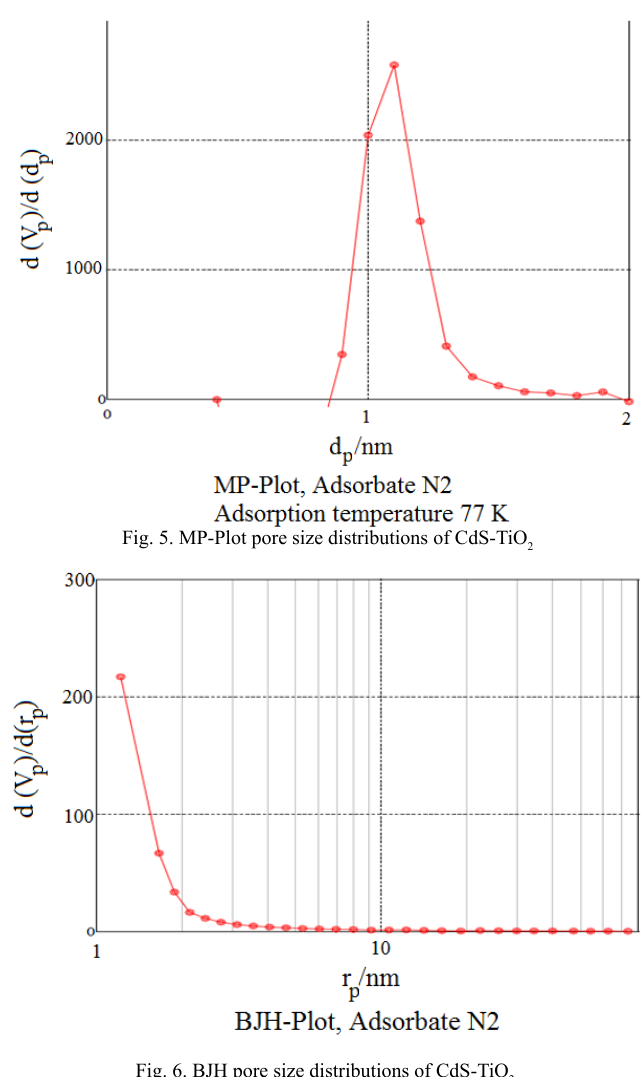
Fig. 6. BJH pore size distributions of CdS-TiO